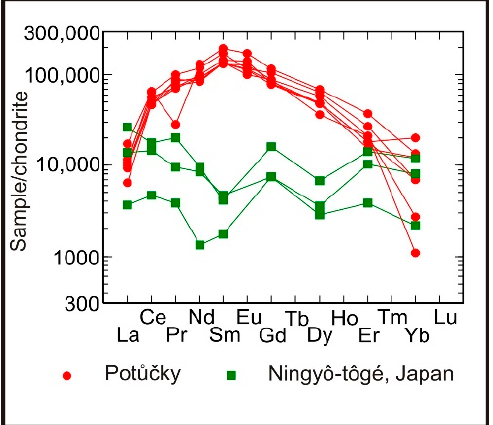
Figure 15. Chondrite-normalised rare earth element patterns for ningyoite from the Pot ůč ky and Ningyô-tôgé uranium deposits. Chondrite values are from Anders and Grevesse [68], data for Ningyô-tôgé deposit are from Muto [67].